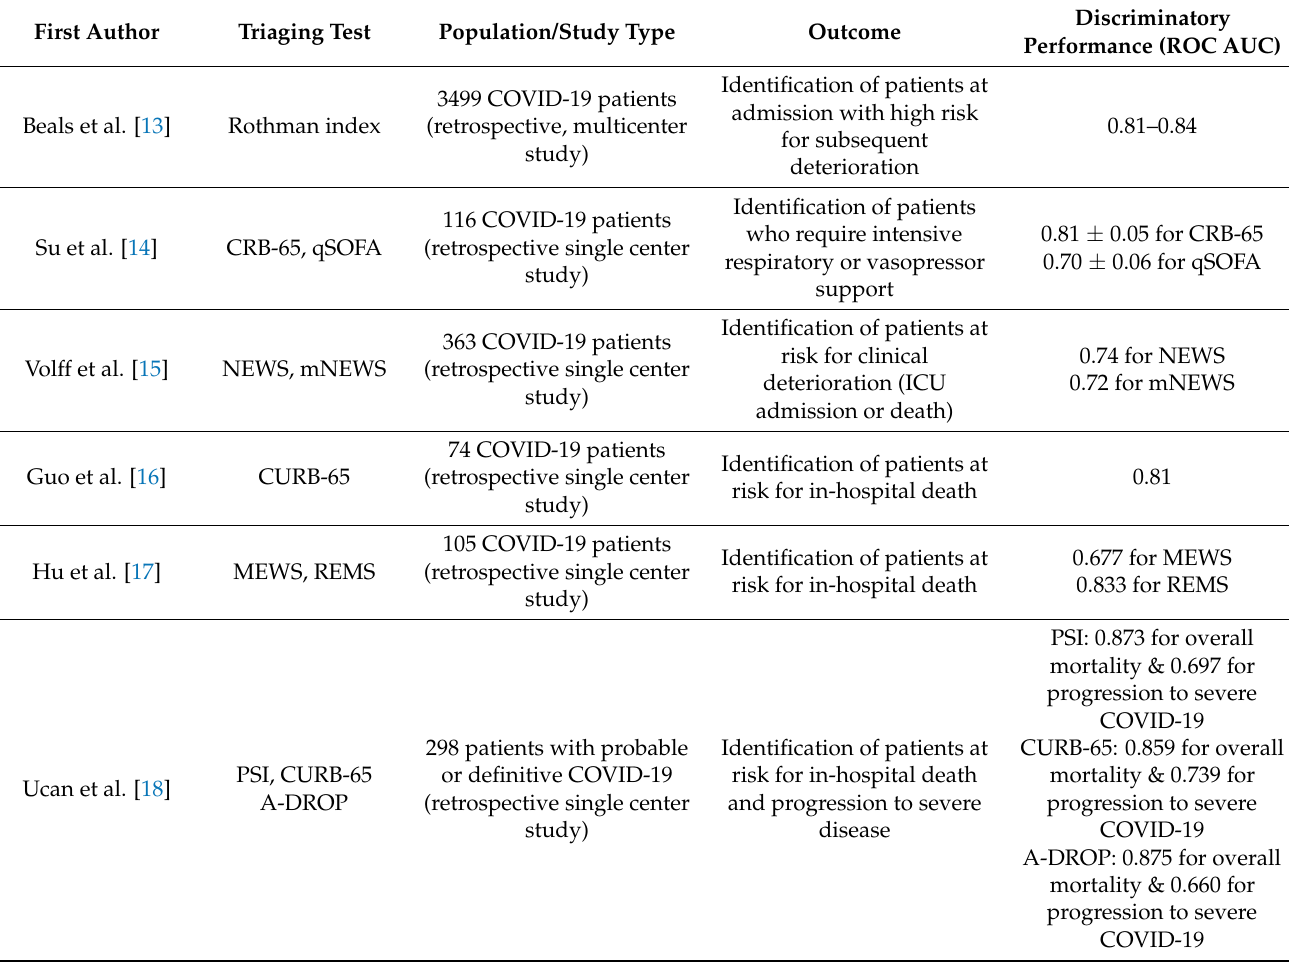
Table 1. Performance of deterioration risk scores in COVID-19